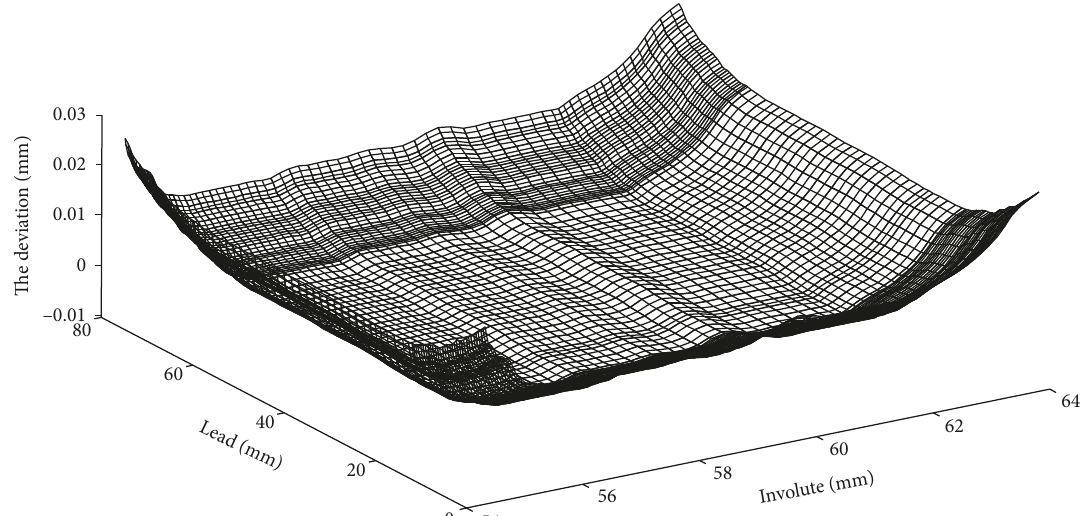
Figure 5: Deviation from theoretical tooth surface.